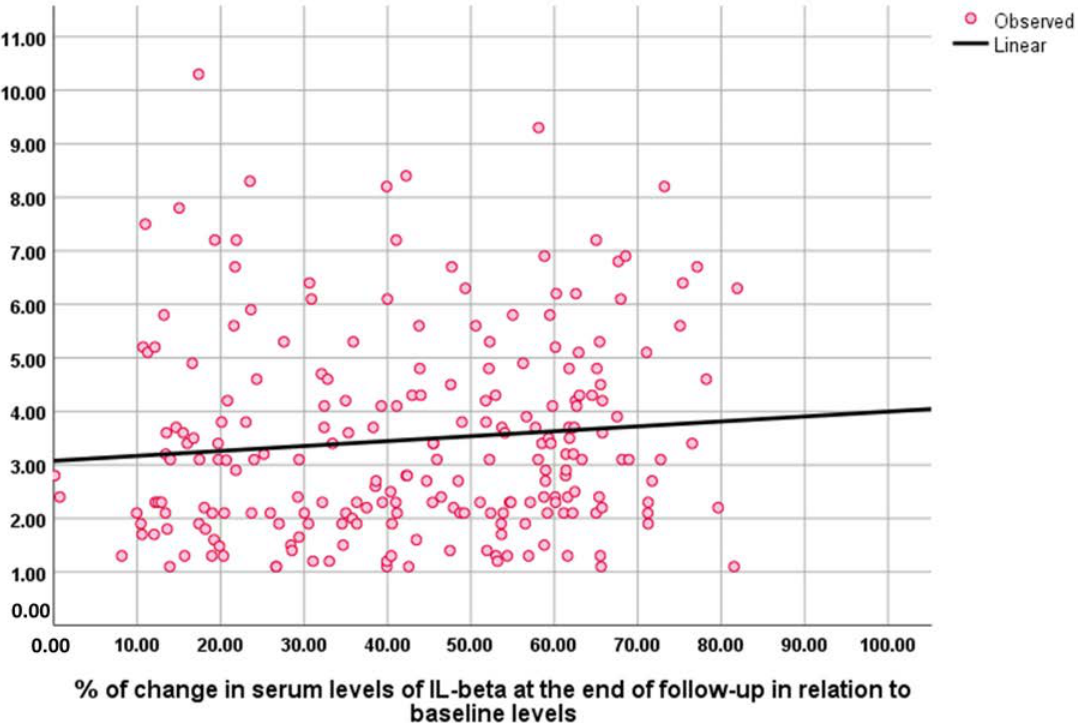
Figure 5. Correlation between the percentage of change in NESPY and serum levels of IL - 1β at the end of the follow-up in relation to baseline